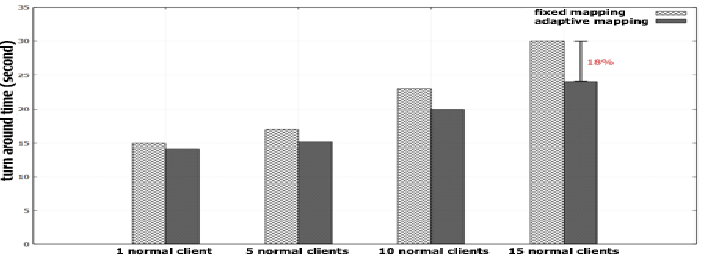
Figure 10. Performance analysis: our adaptive scheme outperforms the fixed scheme when there is no urgent